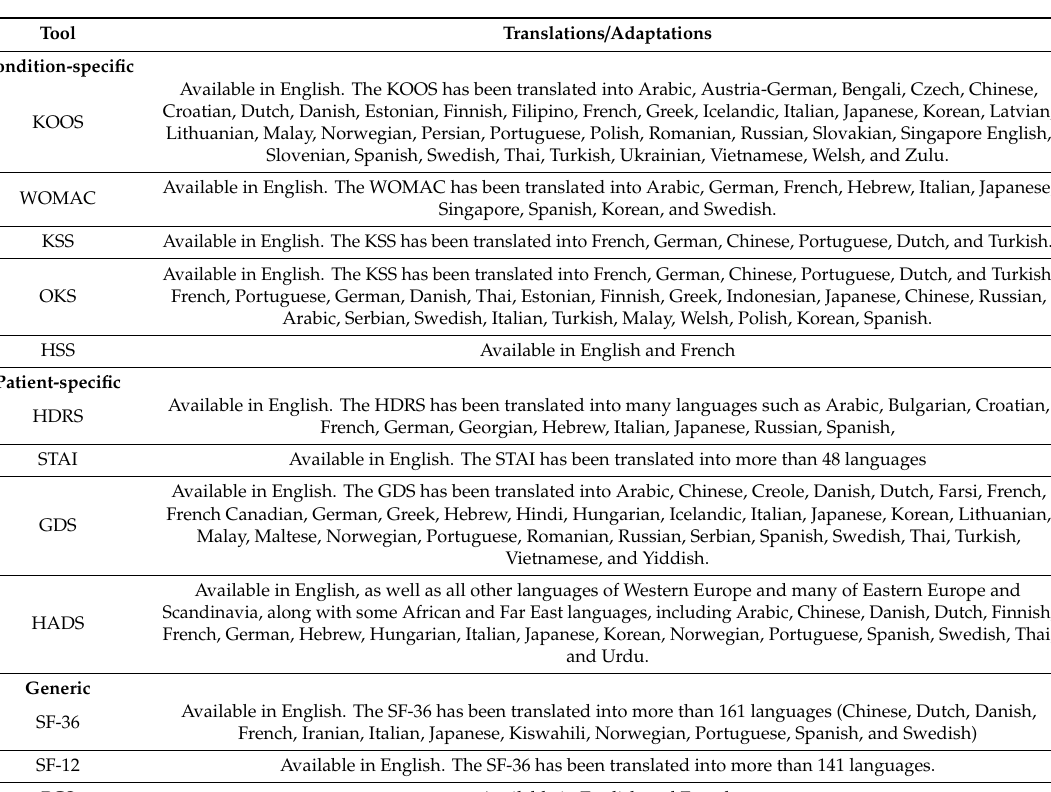
Table A3. Cultural translation / adaptation for each